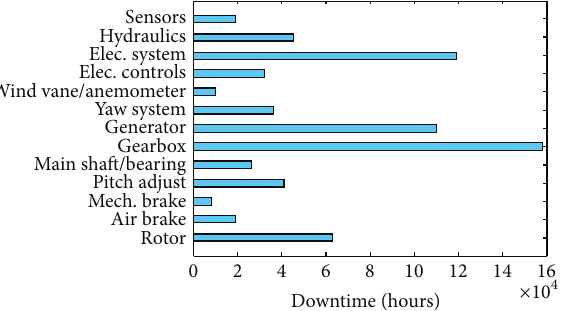
Figure 1: Wind Stats: 2003–2009 aggregated downtime per turbine